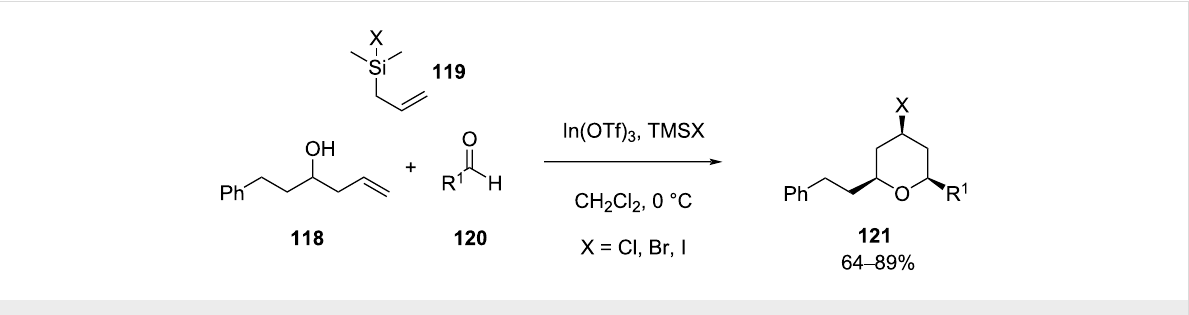
Scheme 28: Loh and Chan’s strategy for THP